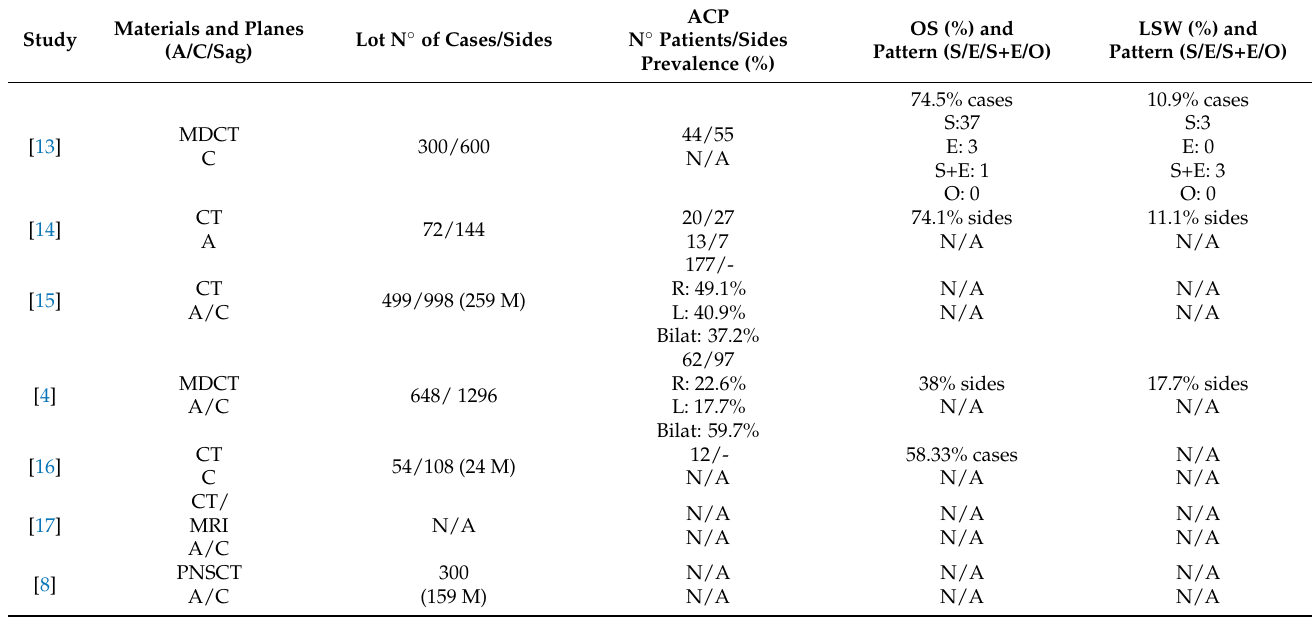
Table 4. Literature review of the anterior clinoid process (ACP), optic strut (OS), and simultaneous OS and anterior root of the lesser sphenoidal wing (LSW)